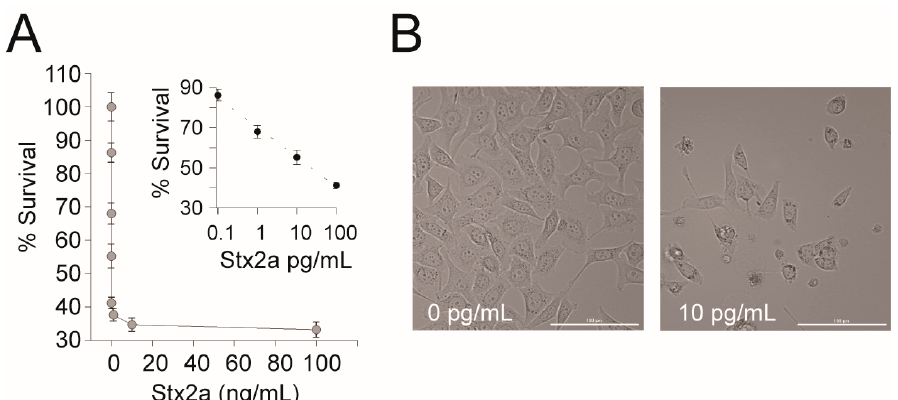
Figure 2. HeLa cell assay for Stx2a activity. ( A ) A representative dose response curve of Stx2a-treated HeLa cells. HeLa cells were treated with 10-fold serial dilutions of Stx2a from 10 fg/mL to 100 ng/mL in DMEM for 24 h at 37 °C with 5% CO 2 . Cell viability was measured using Cell Titer Glo and luminescence was measured on a Victor3 plate reader. Percent survival was calculated as (CPS of the experimental well/CPS of the DMEM only control) × 100%. Inset: The linear portion of the semi-log transformed curve. The dashed line is the best-fit equation used to calculate the CD 50 ( y = − 6.425 ln( x ) + 70), R 2 = 0.99. Error bars represent the standard deviation of the mean from three replicates. ( B ) Representative images (20× magnification) of HeLa cells intoxicated with Stx2a or a medium-only control. Scale bar is 100 μ m.